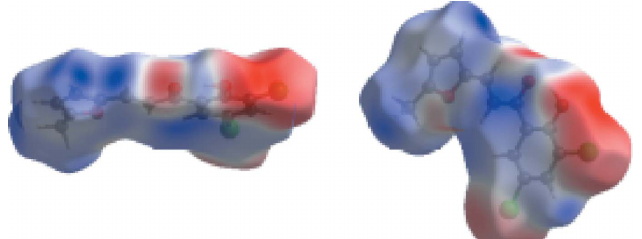
Figure 5 The Hirshfeld surface mapped over electrostatic potential in the range (cid:4) 0.0506 to +0.0422 a.u. The donor and acceptor atoms participating in these interactions are shown respectively as positive (blue regions) and negative electrostatic potentials (red regions).